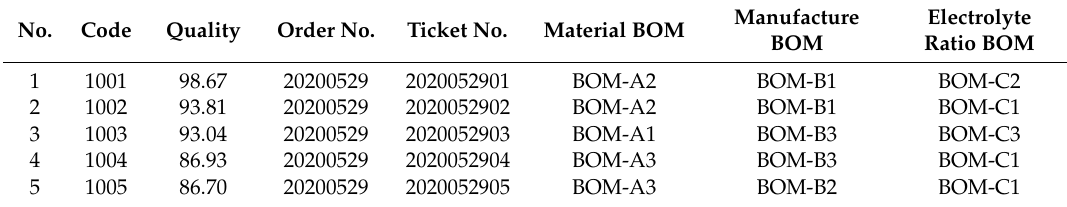
Table 9. Order and BOM information corresponding to